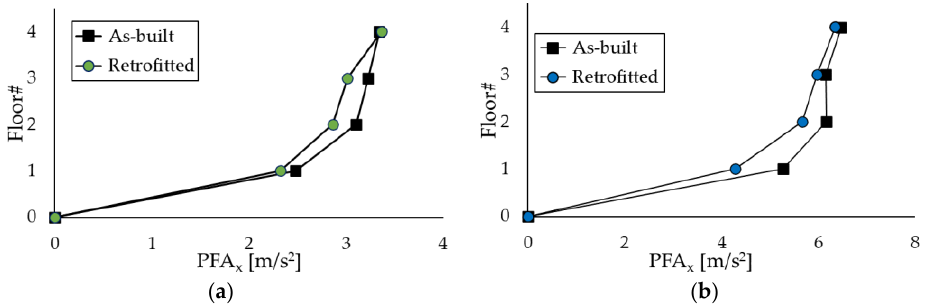
Figure 16. Peak floor acceleration PFA in the X-direction obtained by NLDAs: ( a ) RC structure, and ( b ) steel MRF.